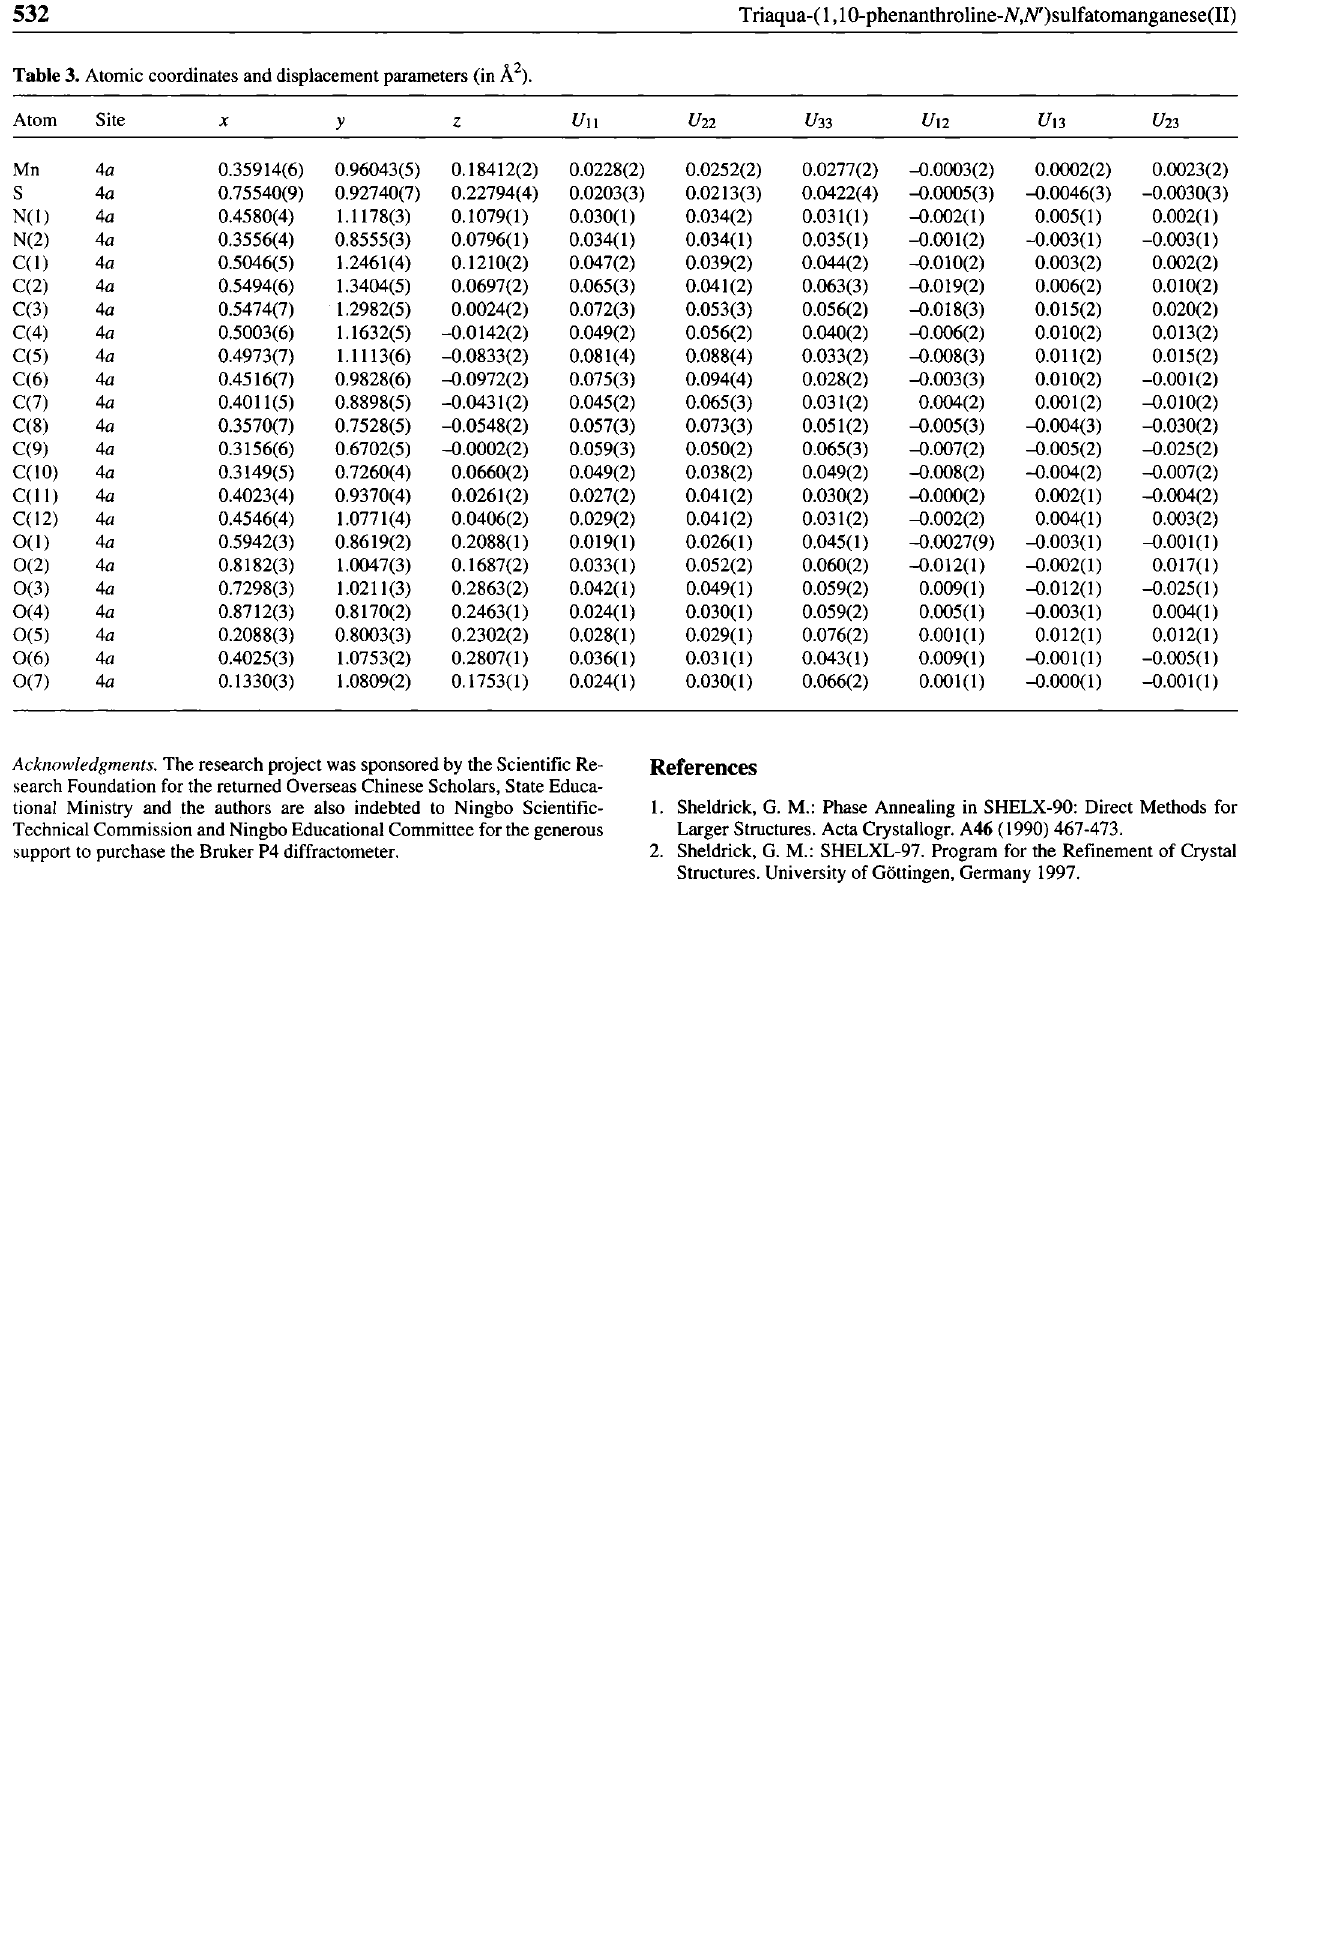
Table 3. Atomic coordinates and displacement parameters (in Â 2